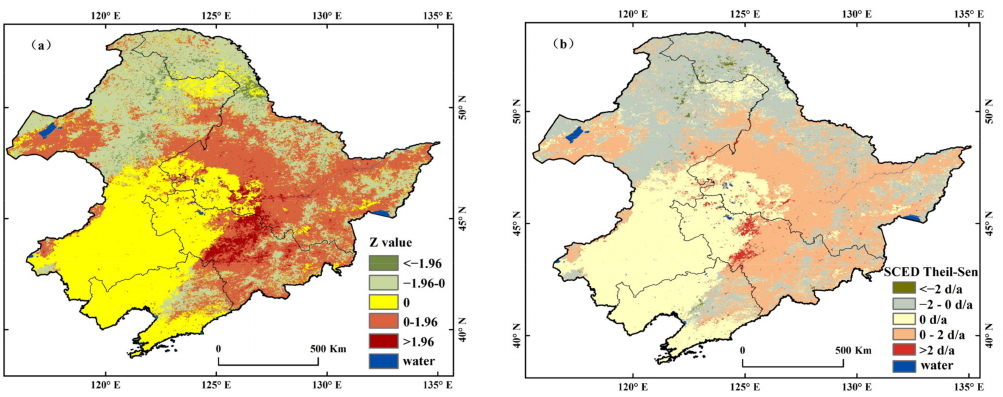
Figure 11. Trend of SCEDs in Northeast China. ( a ) Significance test and ( b ) trend of SCED from HY2001 to HY2017.